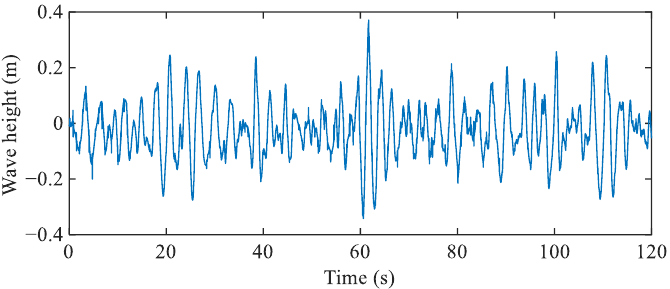
Figure 6. The time-history curve of wave height corresponding to a significant height of 0.3 m and a period of 1.4 s.